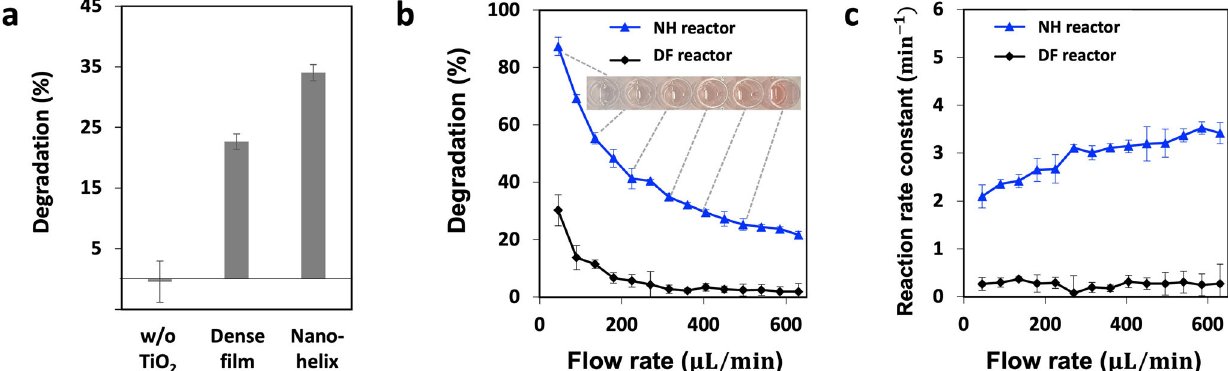
Fig. 2 Water puri fi cation capacity by photocatalytic degradation. a The Rh6G degradation of the cases without TiO 2 , with dense TiO 2 fi lm, and with TiO 2 nanohelix structures without fl ow for 90 min of UV-light illumination. b The Rh6G degradation and c reaction rate constant of the TiO 2 dense fi lm-based microreactor (DF reactor) and TiO 2 nanohelix-based microreactor (NH reactor). Inset in B presents an optical image of the resultant puri fi ed Rh6G solutions injected at different fl ow rates. Gray dotted lines connect the corresponding fl ow rate. The error bars represent the standard deviations of at least fi ve times repeated